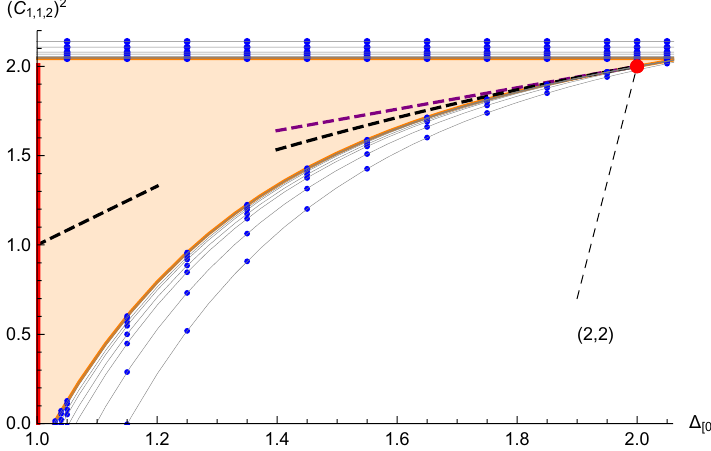
Figure 6 . Upper/Lower Bounds on the OPE coe(cid:14)cient C 2 for (cid:3) = 10 ; 20 ; : : : ; 80. The allowed 1 ; 1 ; 2 region for (cid:3) = 80 is shaded. The point ((cid:1) = 2 ; C 2 = 2) represented by a bigger red dot is [0 ; 0] 1 ; 1 ; 2 occupied by the solution (C.1) with (cid:24) = 1. The thick red line refers to the solutions with (cid:0) 1 (cid:20) (cid:24) < 1. For a given (cid:3), the value of (cid:1) for which a non-trivial lower bound on C 1 ; 1 ; 2 appears is the value of [0 ; 0] (cid:1) for which there is a kink on the r.h.s. of (cid:12)gure 3. The black dashed line starting from the point [0 ; 0] (1 ; 1) represents the behaviour of Wilson lines in planar N = 4 SYM for which (cid:1) = 1+ (cid:21) + : : : [0 ; 0] 4 (cid:25) 2 as (cid:12)rst computed in [65] and C 2 = 1+ (cid:21) + : : : as follows from localization. The (upper) purple and 112 24 (lower) black dashed curves starting from the point (2 ; 2) are the (cid:12)rst and second order perturbative approximation of the lower bound curve given by (6.29), compare to